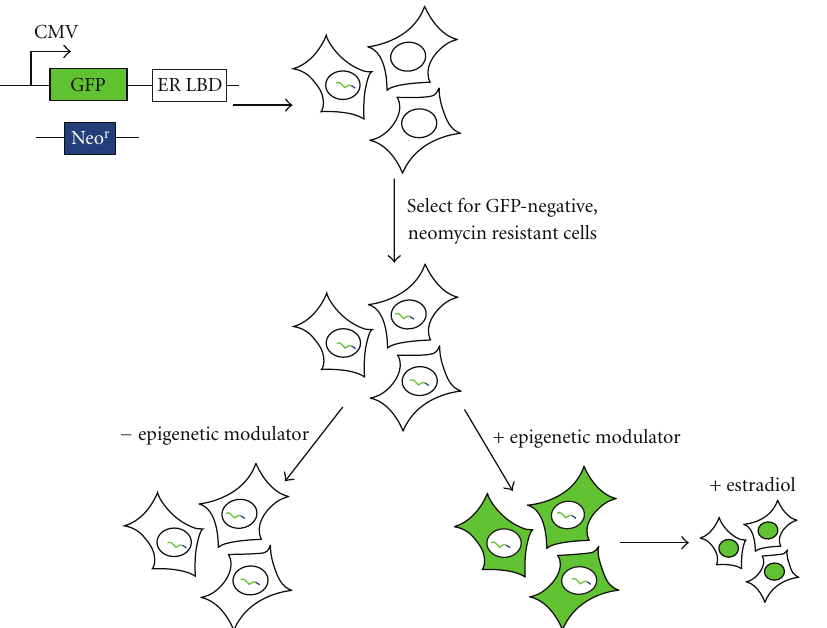
Figure 1: Schematic representation of the process of creating transgenic mouse mammary adenocarcinoma cells (locus derepression assay cells or LDR) [29]. A construct containing the GFP gene linked to the estrogen receptor ligand-binding domain, driven by the CMV promoter and a neomycin resistance marker, was stably transfected into cells. GFP negative cells, stably expressing the neomycin resistant gene, were selected. With the addition of an epigenetic modulator, such as an HDAC inhibitor or a DNA methyltransferase inhibitor, the cells express GFP and can be visualized by fluorescence microscopy. When cells are then treated with estradiol, the GFP fusion protein translocates to the